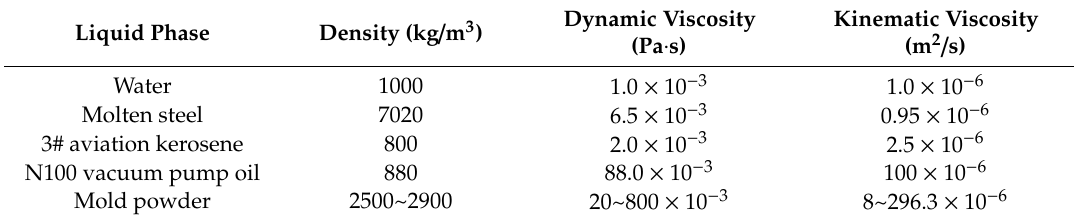
Table 5. Physical parameters of di ff erent substances